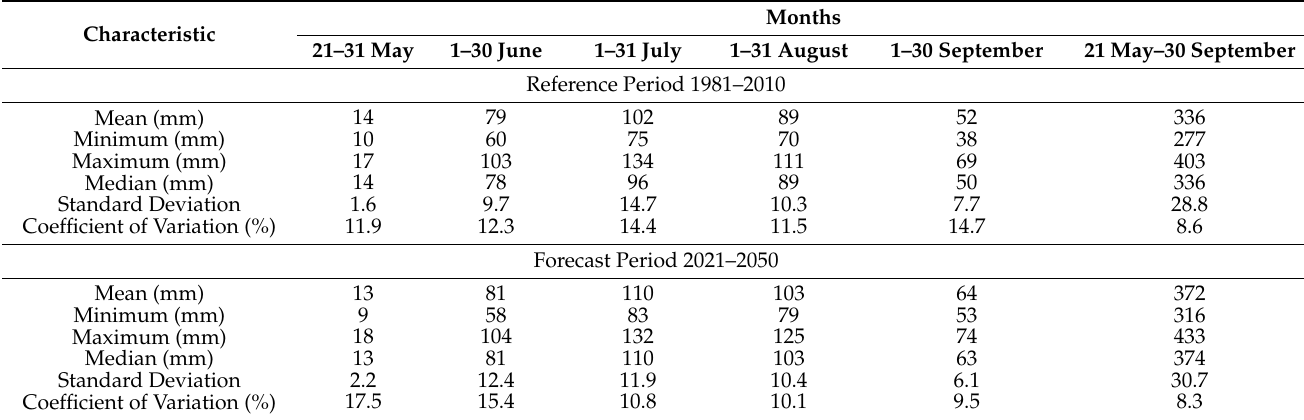
Table 2. Statistical characteristics of the giant miscanthus water needs determined as potential evapotranspiration (mm) during the intensive growth season in the reference and forecast years.